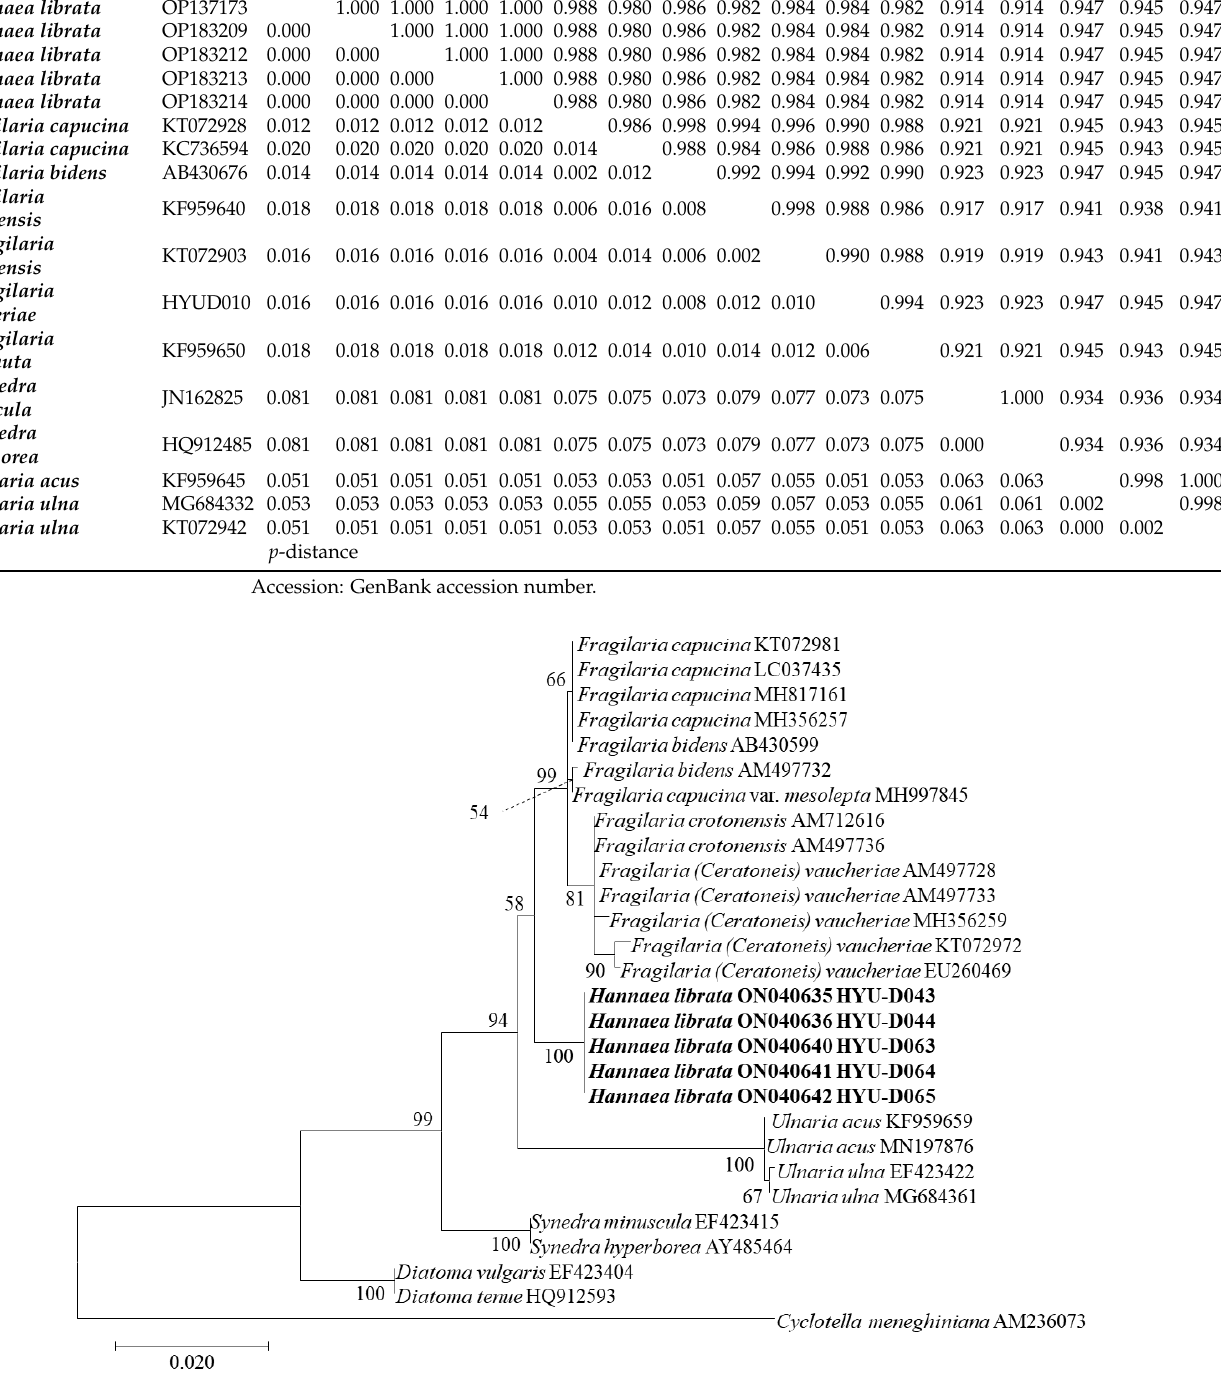
Figure 4. SSU rRNA maximum likelihood phylogenetic tree of Hannaea librata sp. nov. and other species. The tree with the highest log likelihood ( − 3434.22) is shown. The percentages of trees in which the associated taxa clustered together are shown next to the branches. The analysis included 28 nucleotide sequences and 1478 positions in the final data set. Cyclotella meneghiniana was used as an outgroup.